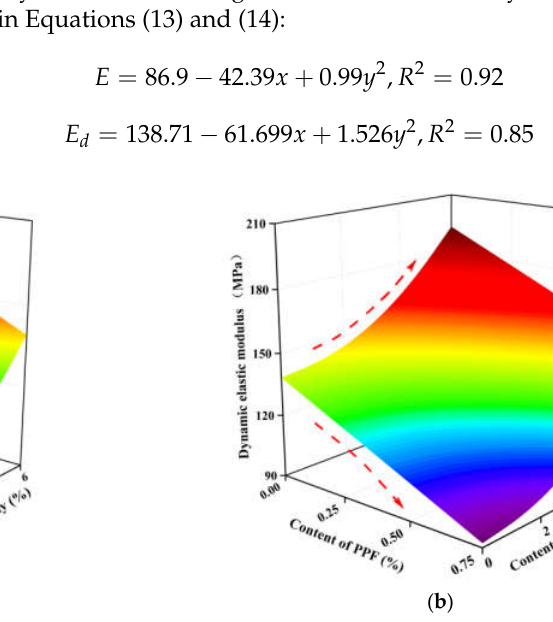
Figure 11. Influence of PPF and nano clay content variation on elastic modulus prediction model: ( a ) static elastic modulus; ( b ) dynamic elastic modulus.